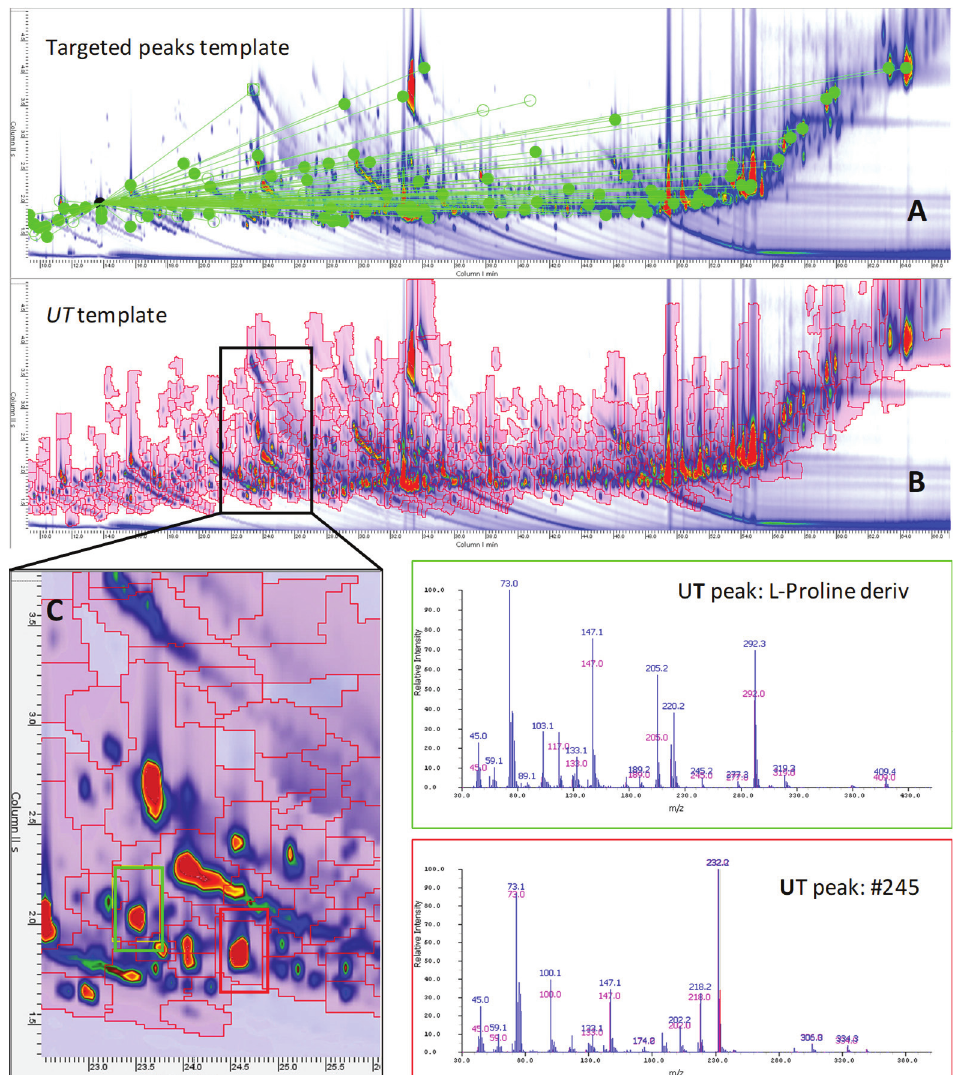
Figure 1. Contour plot of a Yunnan sample harvested in 2014 from high elevation and harvested after the monsoon season (2014_YUN_HM). ( A ) The distribution of targeted 2D peaks (green circles) while connection lines point to the IS (i.e., 1,4-dibromobenzene). ( B ) The distribution of untargeted–targeted (UT) peak-regions (red graphics) comprehensively covering the chromatographic space. Enlarged area of ( C ) highlights the position of the targeted peak (green squared) L -Proline and of the untargeted feature #245. Corresponding spectra are also reported.